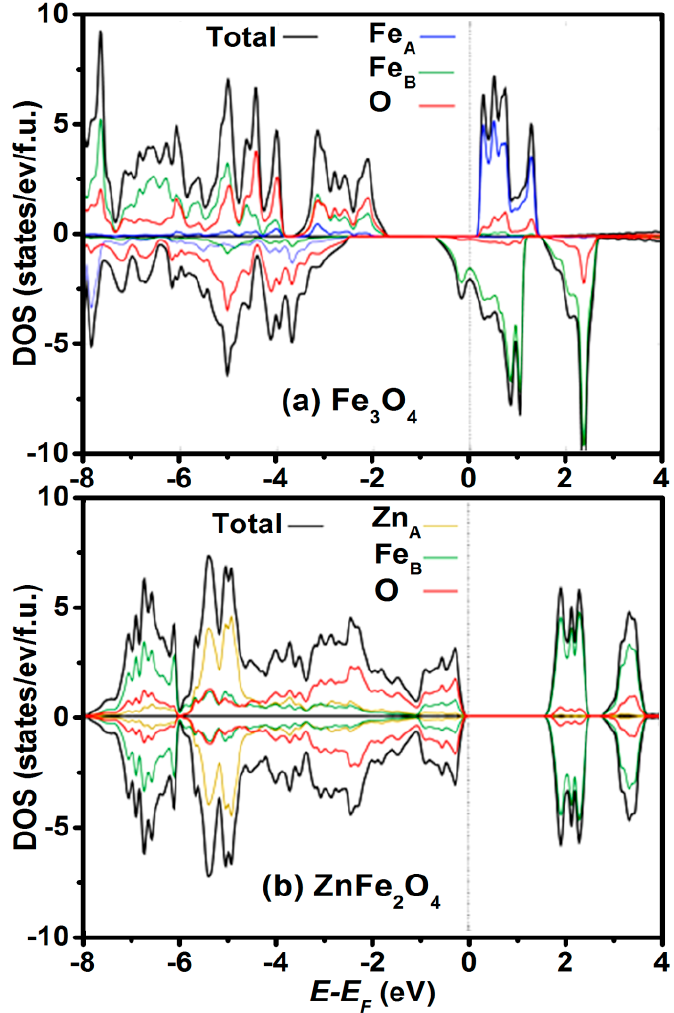
Figure 4. Spin-projected densities of states (DOS) of the Zn y Fe 3 − y O 4 bulk compound obtained from the DFT calculations, using a GGA+ U ( U (Fe,3d) = 4.0 eV) approximation. ( a ) y = 0 corresponds to the half-metallic and ferrimagnetic magnetite Fe 3 O 4 and ( b ) y = 1 to the insulating and antiferromagnetic ZnFe 2 O 4 . Positive and negative DOS represent, respectively, the projection onto majority and minority spin states.